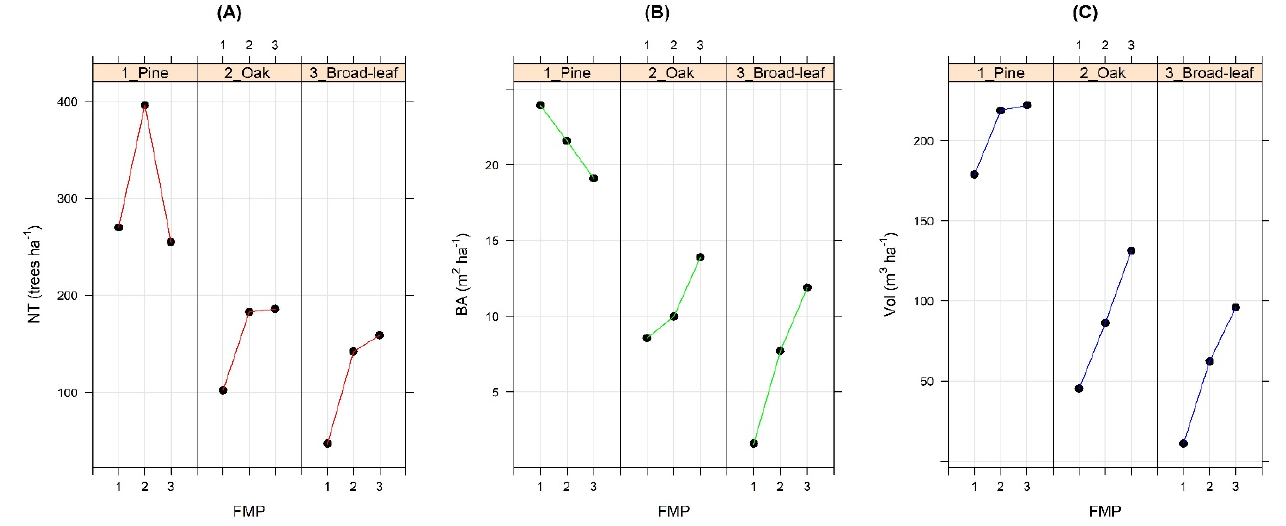
Figure 9. Comparison of number of trees ( NT ) ( A ), basal area ( BA ) ( B ), and volume ( Vol ) ( C ) of the three forest management plans (FMPs) in the P0301 sub-stand.